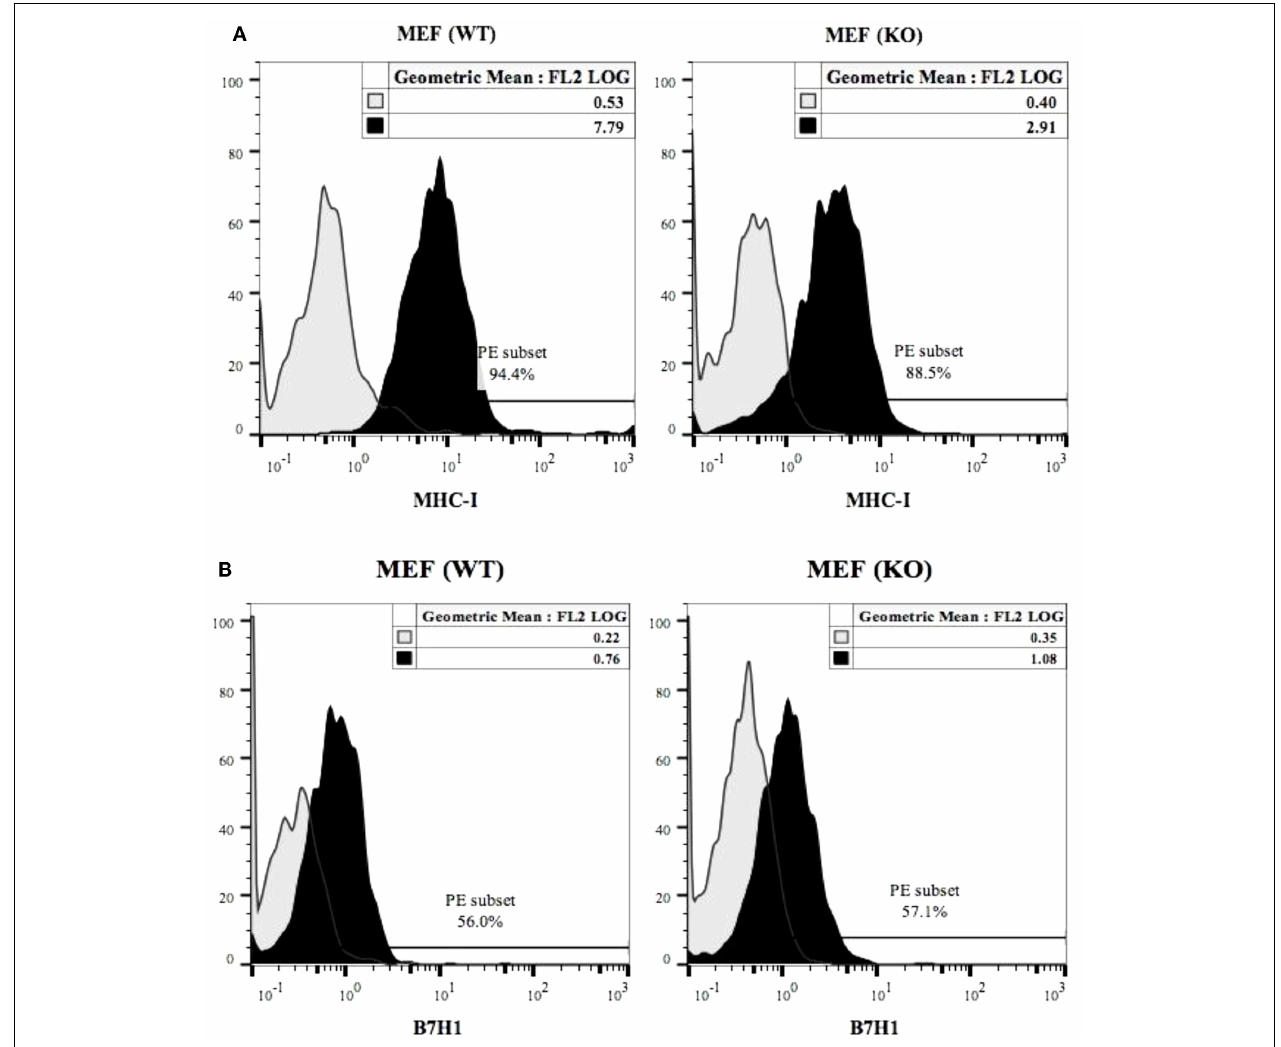
FIGURE 5 | MHC class-I, B7H1 and CD54 surface receptor analysis on wild type and COX-2 knockout MEFs